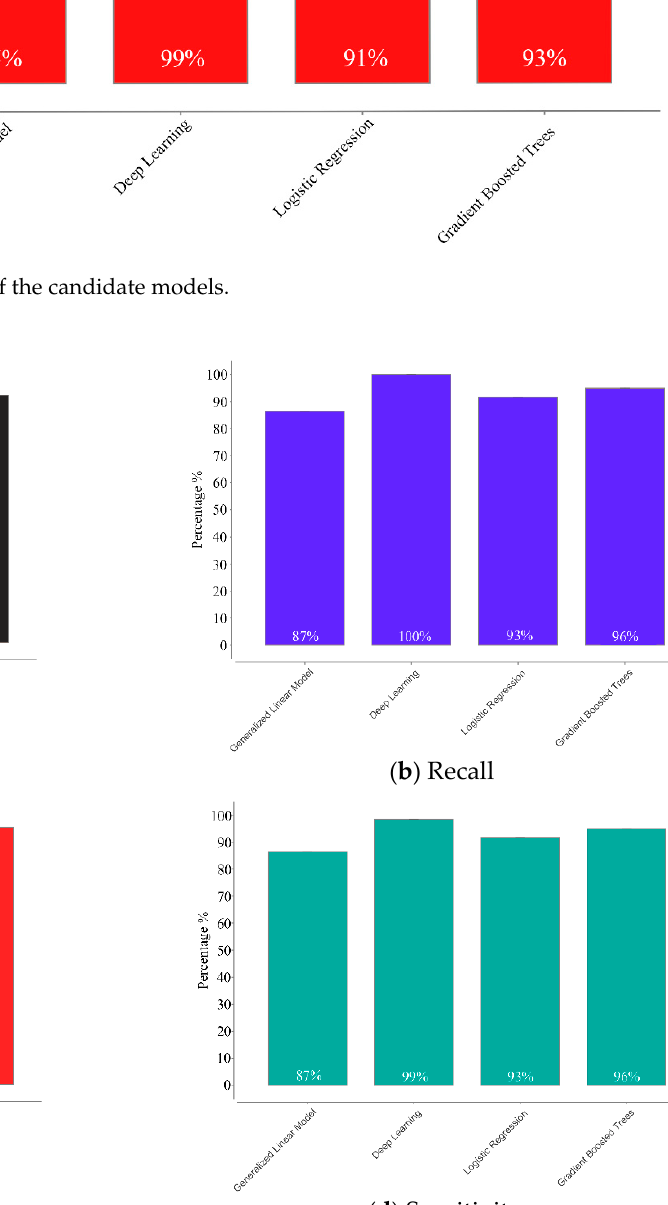
Figure 5. Accuracy of the candidate models.